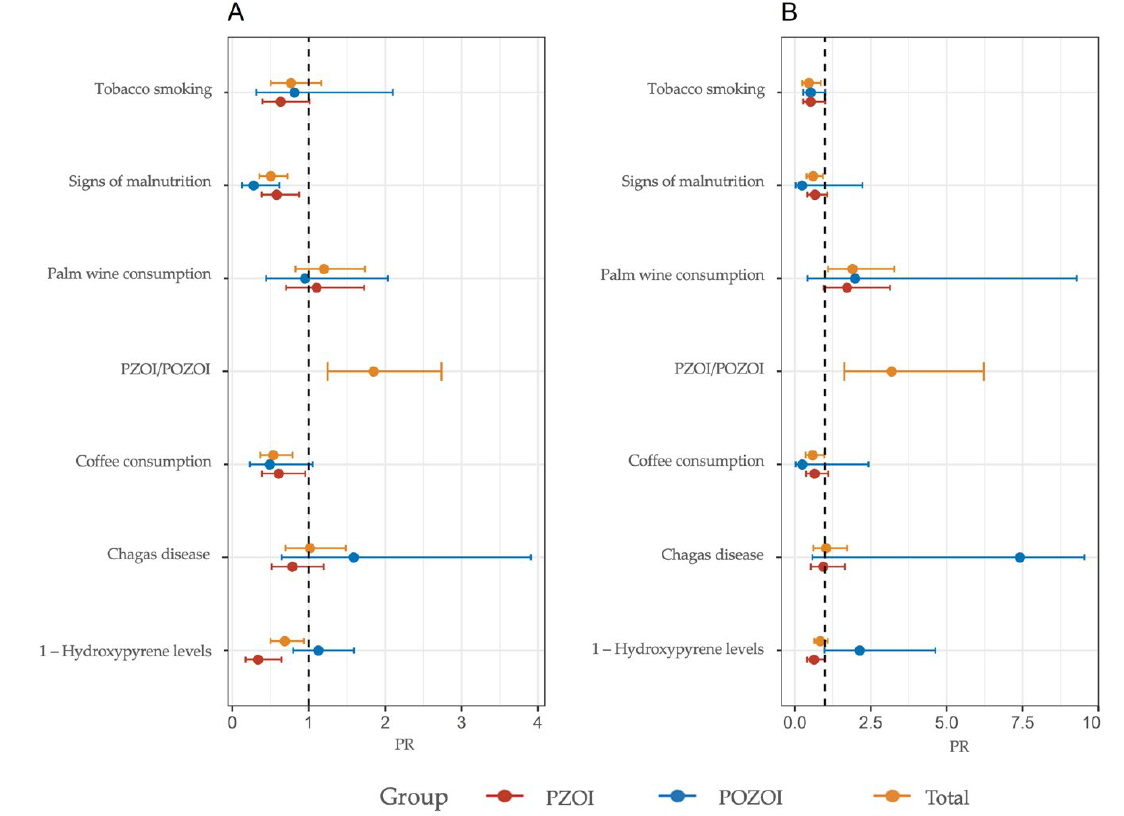
Figure 4. PR for NBUDs frequency based on a Poisson regression model for PZOI and POZOI groups. ( A ) Unadjusted and ( B ) adjusted for covariates.